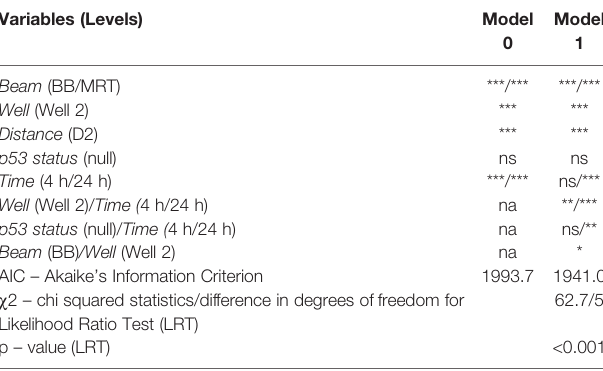
TABLE 1 | Comparison of two linear models of response (mean foci per cell count) and statistical signi fi cance of response